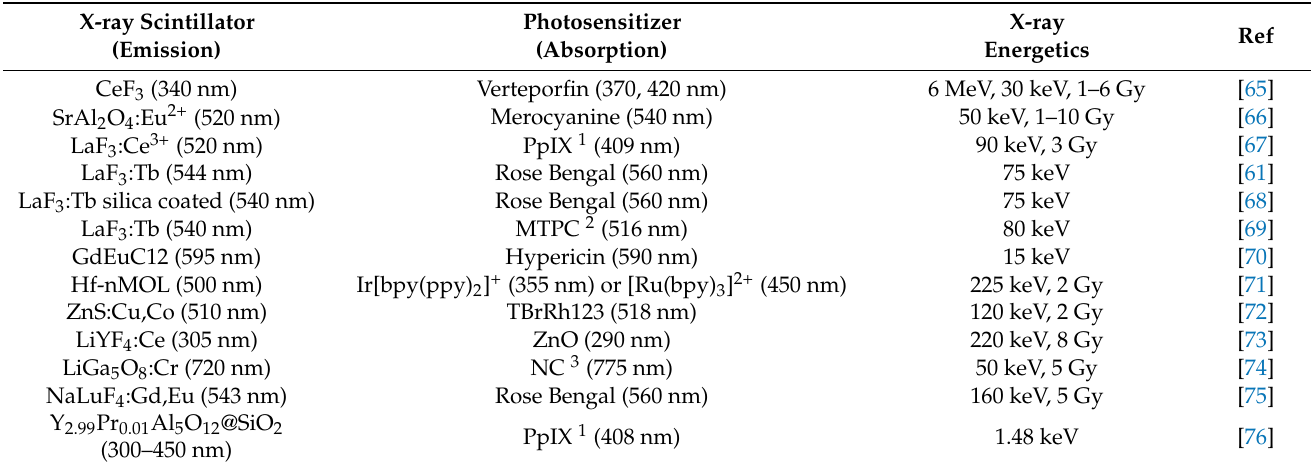
Table 2. Some SCNPs (nanoscintillators and photosensitizers) used in X-PDT. The energy required to activate them is also presented. Adapted from [29,64].